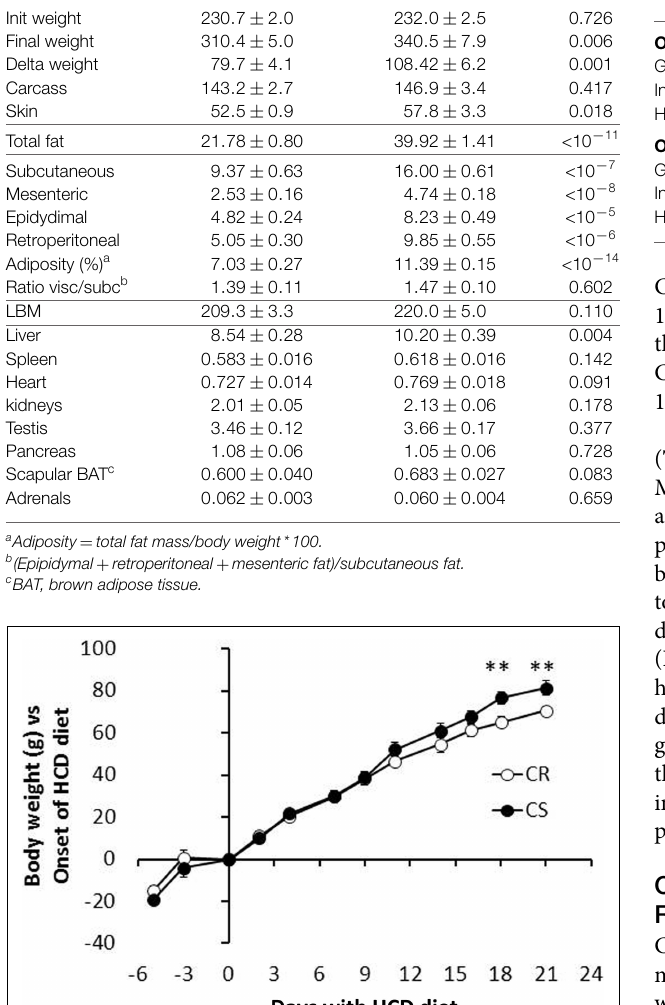
TABLE 4 | Basal blood glucose (mmol/L), plasma insulin (nmol/L), and HOMA index {[glucose (mmol/L) (cid:2) insulin (pmol/L)]/22.5} at the onset of the glucose and meal tolerance tests .